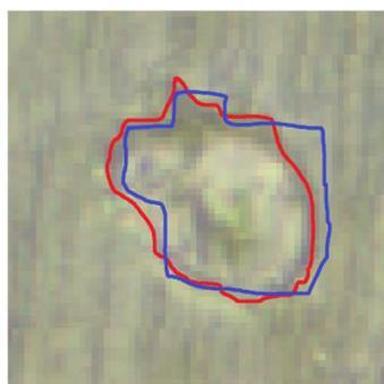
he result of the segmentation of fiber reinforcing elements: the ground truth region in the red circle and the predicted segmentation in blue circle.